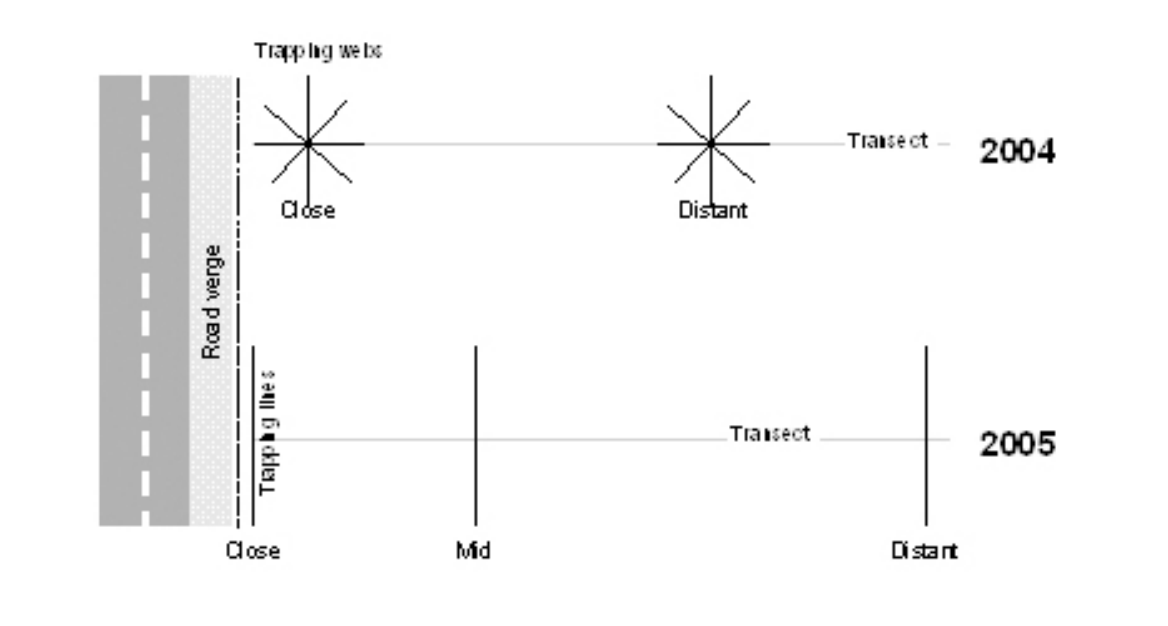
Fig. 2 . Schematic representation of trapping schemes in 2004 and 2005 used in southern Utah,